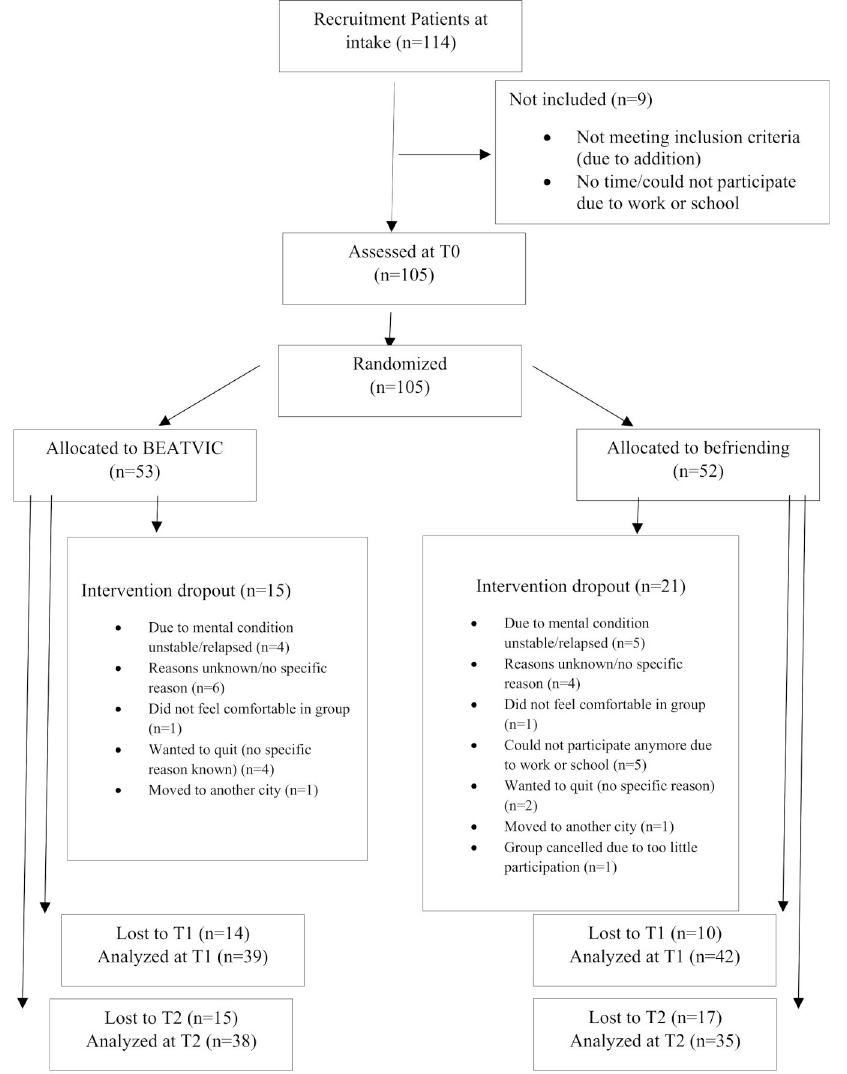
Fig 1. CONSORT diagram of participant